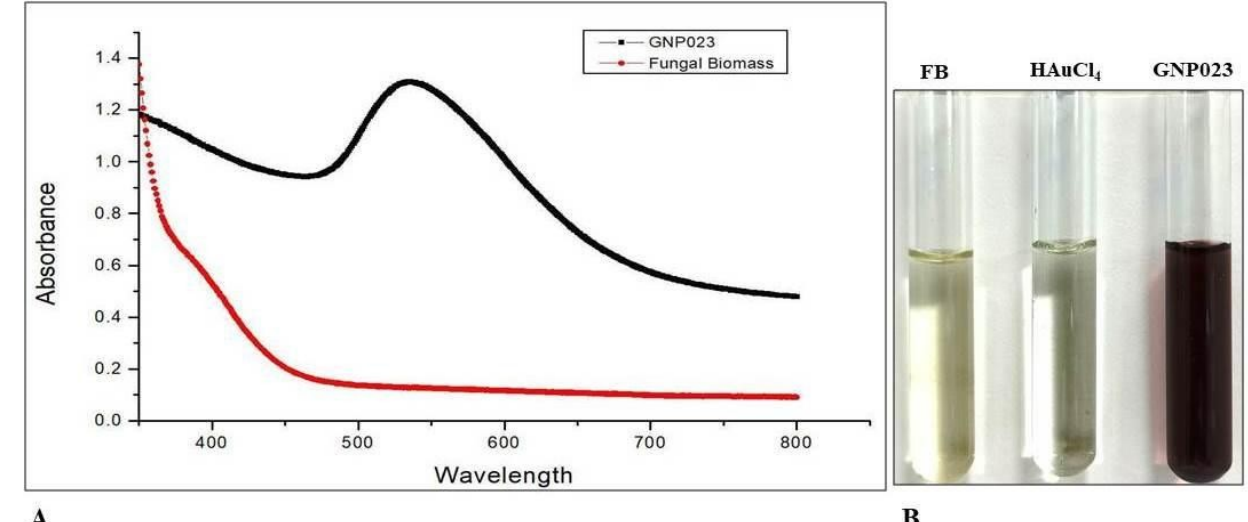
Figure 1. ( A ) UV-absorption spectra of gold nanoparticles GNP023 for reaction of the fungal extract with HAuCl 4 solution and ( B ) comparison between nanoparticles synthesis by HAuCl 4 solution and the biomass of A. terreus AREF023.